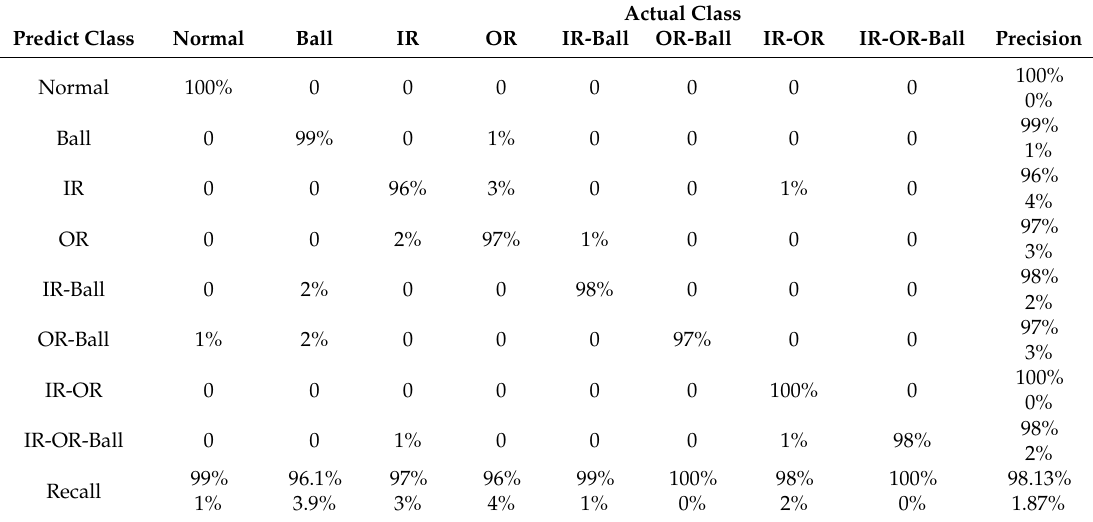
Table 7. Confusion matrix using dataset 2 with the proposed method when the torque speed is 400 RPM and the crack size is 6